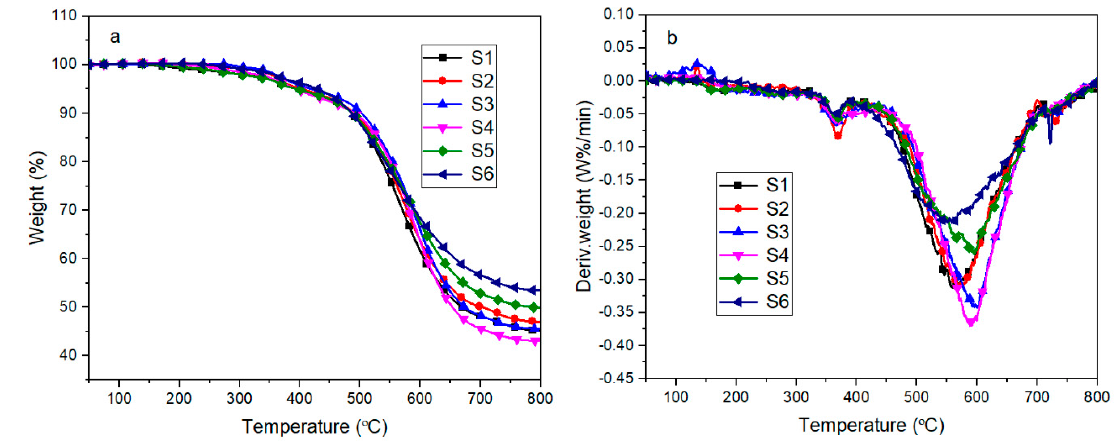
Figure 12. TGA ( a ) and DTG ( b ) curves of SIFs with different MAPOSS content under nitrogen atmosphere. Table 1. The thermal stability of polysiloxane foam with different MAPOSS contents.